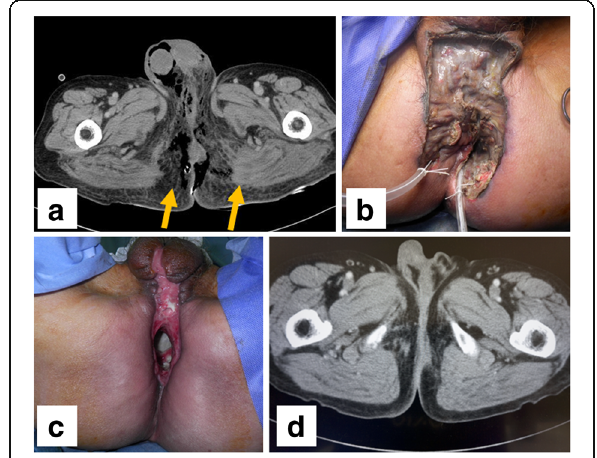
Fig. 1 Computed tomography and pictures of the perineum and buttocks region. Computed tomography showed necrotizing soft tissue infection with large amounts of gas throughout the perineum ( arrows ) ( a ). The necrotic soft tissue in the perineum and buttocks surrounding rectal cancer was resected ( b ). The perineum and buttocks region on day 35 after total pelvic exenteration ( c ). Computed